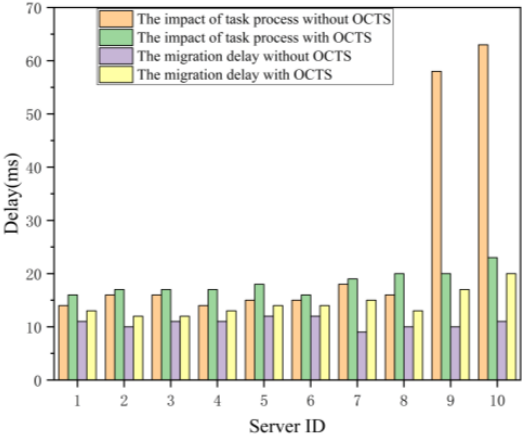
Figure 9. Delay variations on individual servers.